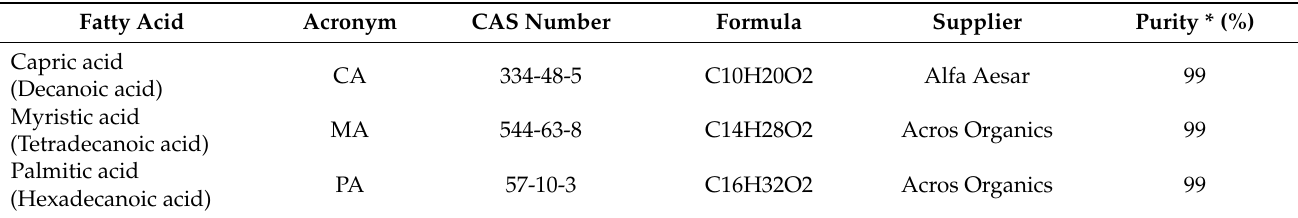
Table 2. General information about the studied fatty acids.